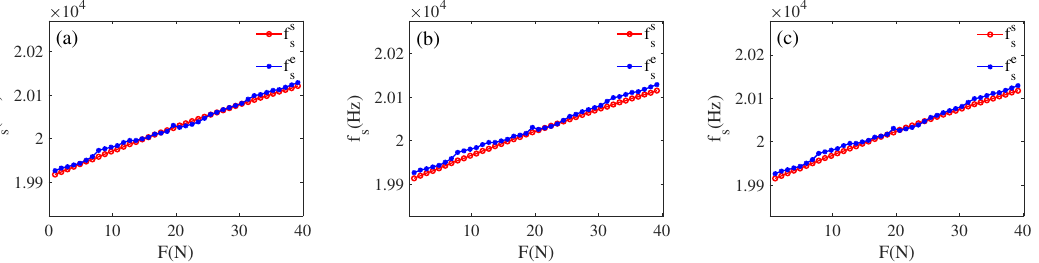
Figure 16. ( a ) f e s and f s s by inscribed circle; ( b ) f e s and f s s by circumcircle; ( c ) f e s and f s s by average.